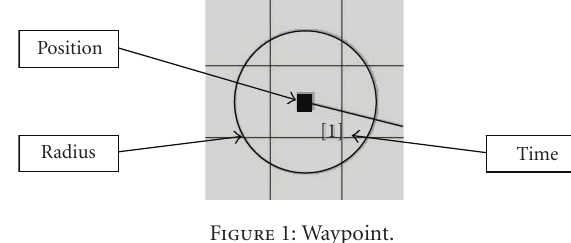
Figure 1: Waypoint.